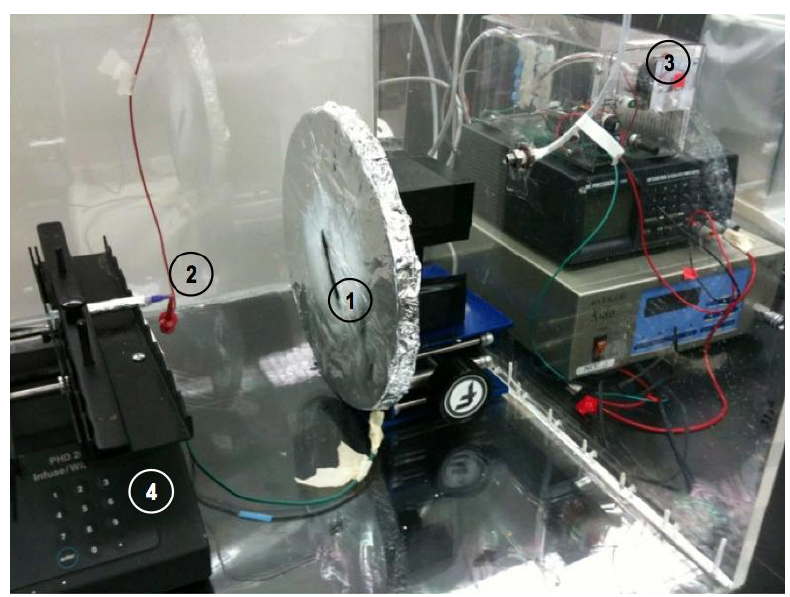
Figure 2. Electrospraying setup used to deposit SU-8 beads on the black absorbing substrate ( 1 ). It is composed of a spraying needle ( 2 ) set at a DC voltage controlled by a high voltage supply ( 3 ) and the polymer is injected through the needle using a syringe pump ( 4